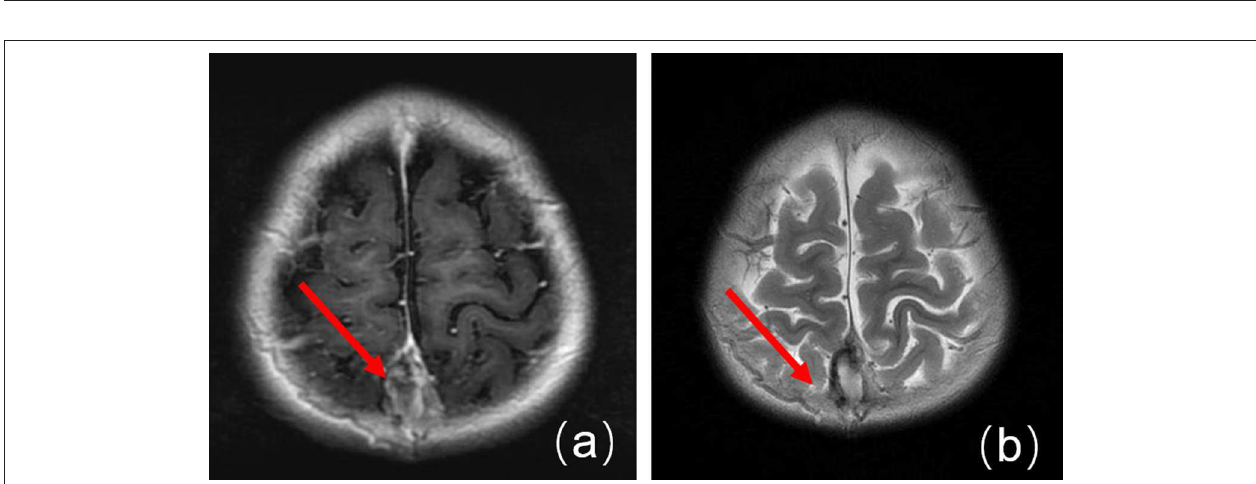
FIGURE 3 | Enhanced MRI before treatment. (a) An MRI image showing a T1WI high-signal in the superior sagittal sinus, plus a slab-like low signal. (b) An MRI image showing a T2WI high-signal in the superior sagittal sinus.